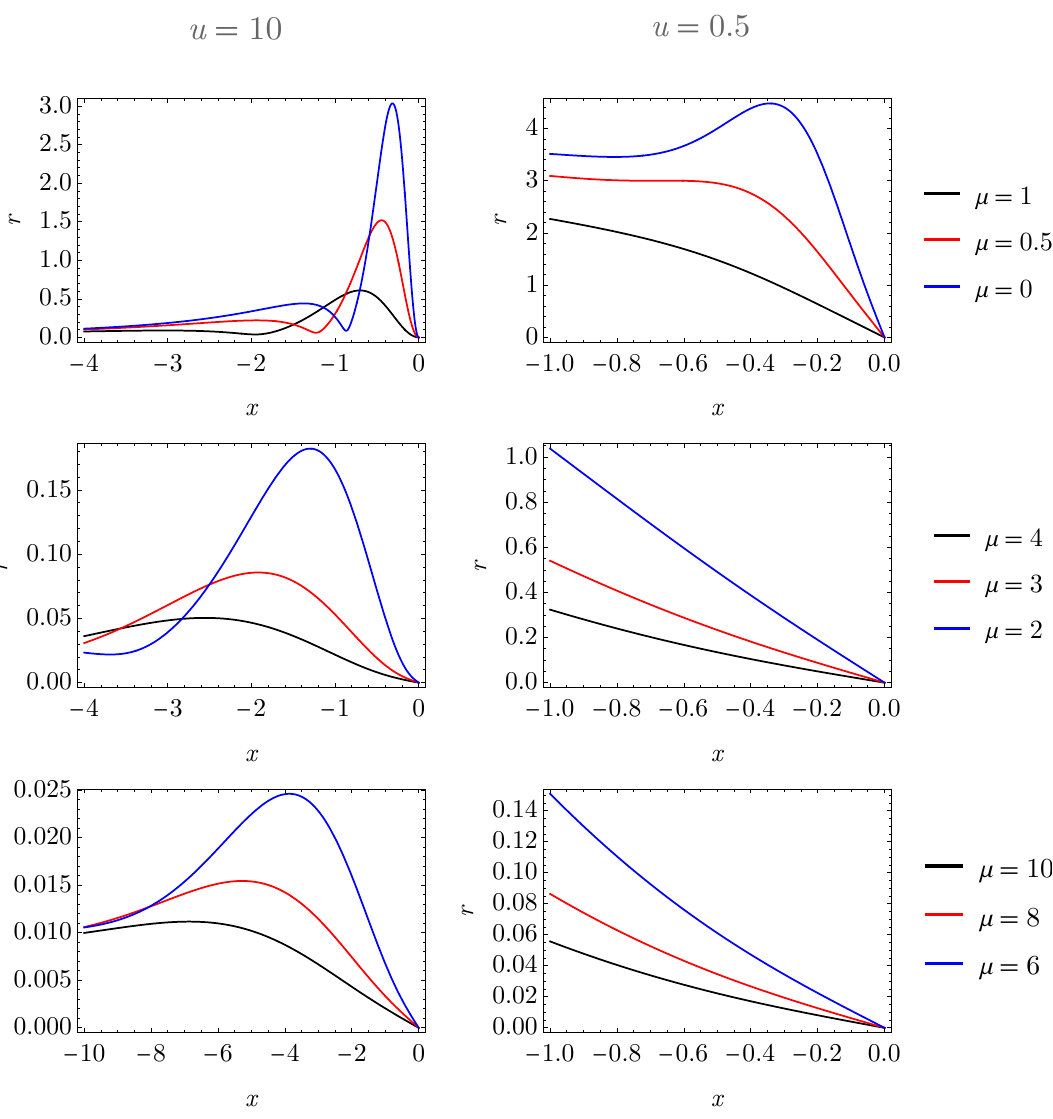
Figure 15 . Plot of r ( u, x ) (6.22) for various values of u and µ . The validity of the EFT requires r (cid:28) 1 for | x | . u , see the text after eq.